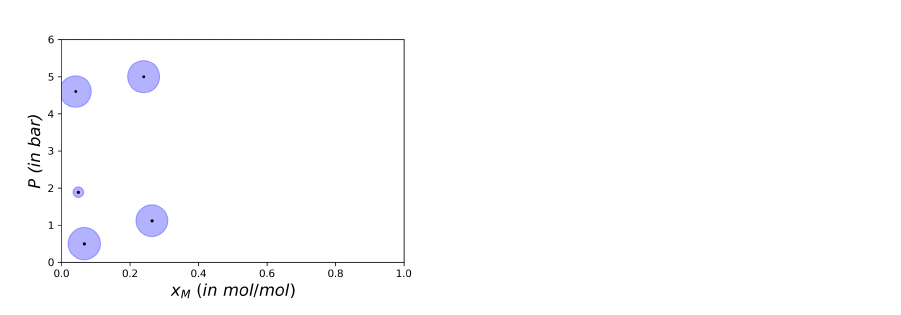
Figure 5. Optimal design ξ ADAGPR in the two-dimensional design space for the flash with a methanol– water input feed, computed with the novel ADA-GPR.